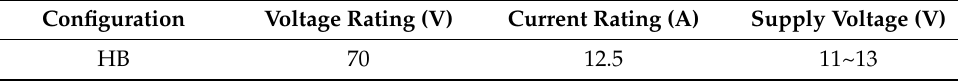
Table 26. Commercial switch-driver-integrated module by EPC.